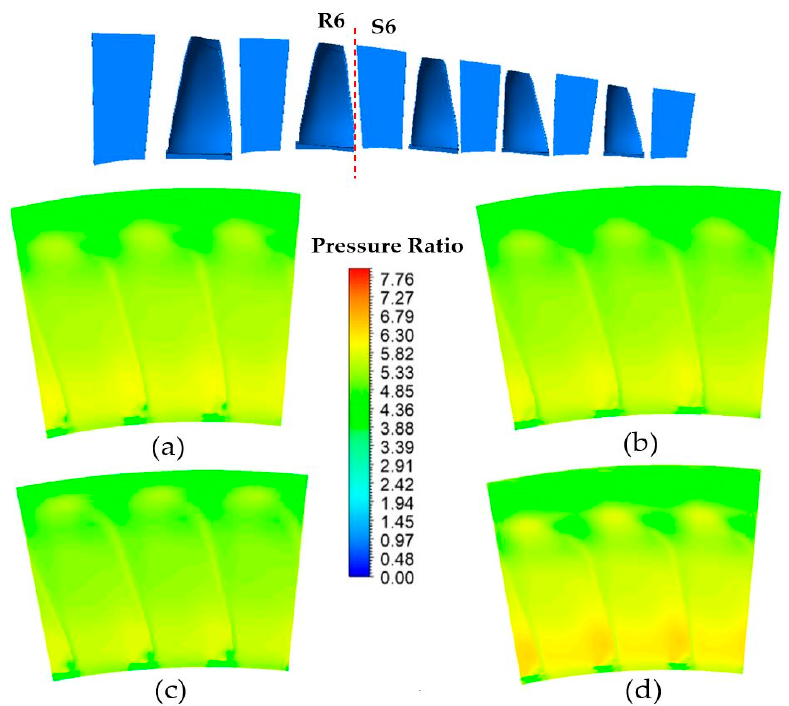
Figure 8. Pressure ratio between the middle plan of R6–S6 of the blade: ( a ) before modification, after modifications of ( b ) 1 mm, ( c ) 5 mm, and ( d ) 10 mm.